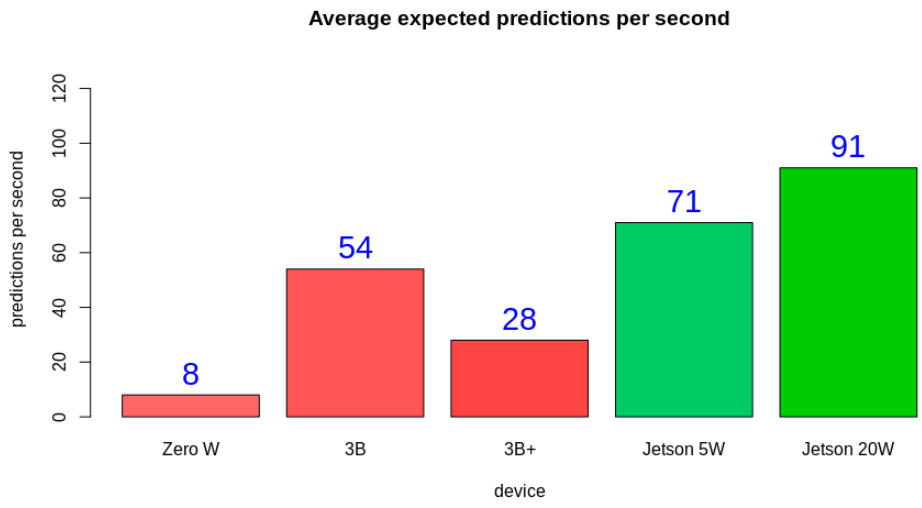
Figure 21. Average expected predictions per second ratio on each platform. The number in blue displays the expected